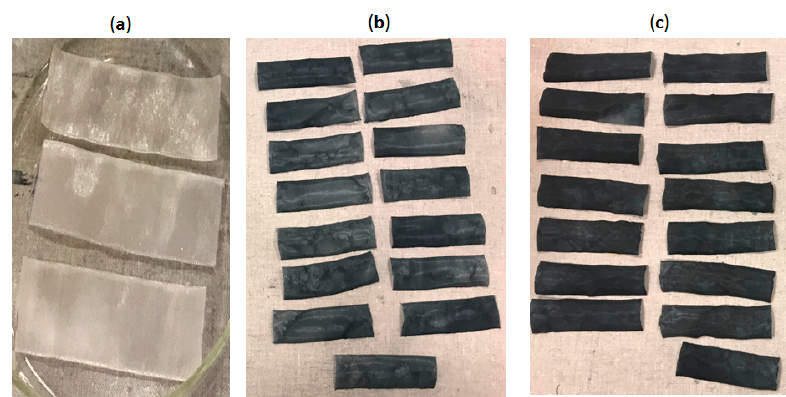
Figure 3. (a) Polyamide textile fabrics before immersion coating; (b) Polyamide textile electrodes coated by PEDOT:PSS (S1); (c) Polyamide textile electrodes coated by PEDOT:PSS (S2).